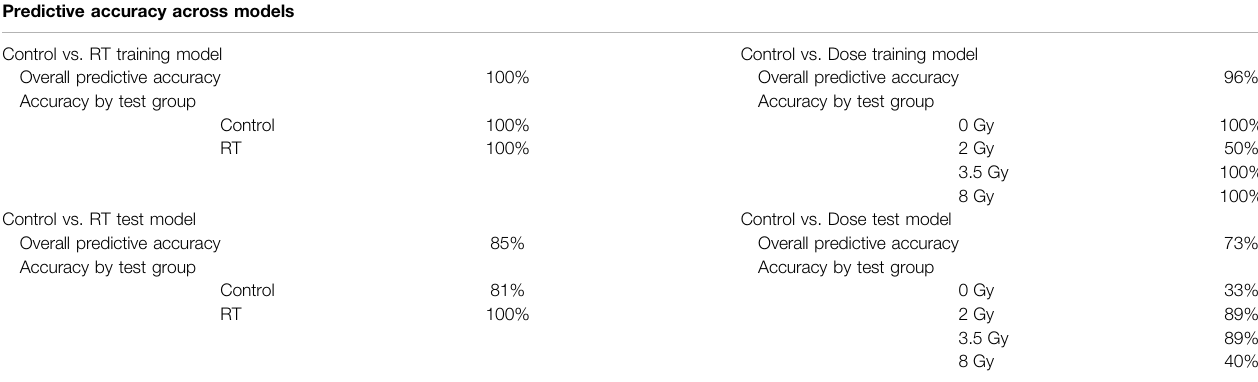
TABLE 2 | Model Predictive Accuracy. Summary of the predictive accuracy scores for each model using a linear discriminant analysis approach. Both overall predictive accuracy scores and predictive accuracy scores by test group were generated for both Control Vs. RT and Control vs. Dose training and test models. Predictive accuracy across models Control vs. RT training